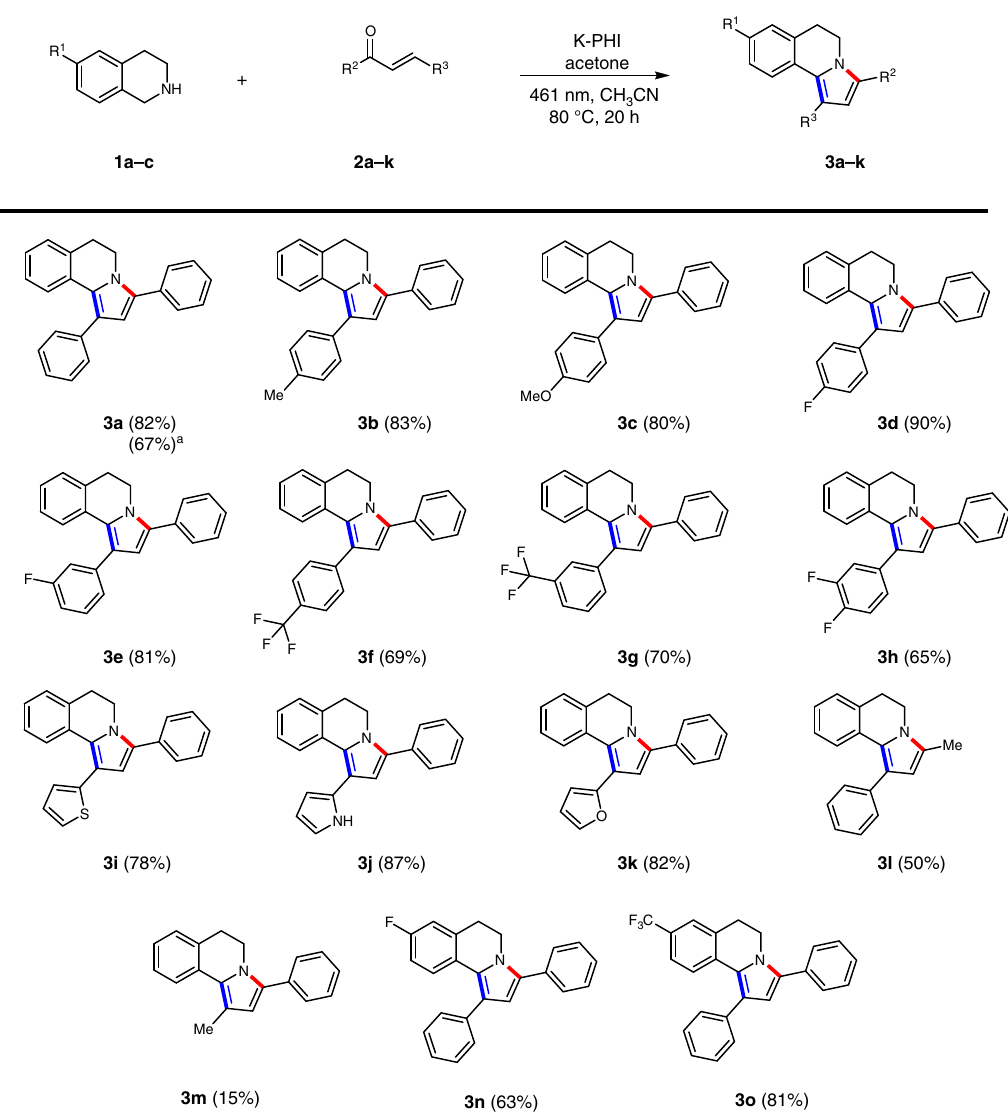
Fig. 2 Scope of dihydropyrrolo[2,1-a]isoquinolines 3a – o synthesized via a photocatalytic cyclocondensation tandem reaction. Isolated yields are given in brackets. Superscript “ a ” indicates the reaction was scaled using 300 mg of the chalcone 2a